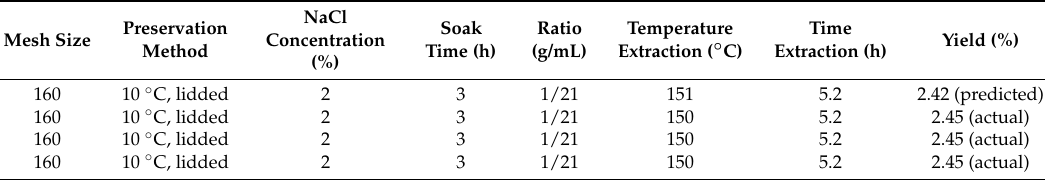
Table 3. Extraction yields at optimum